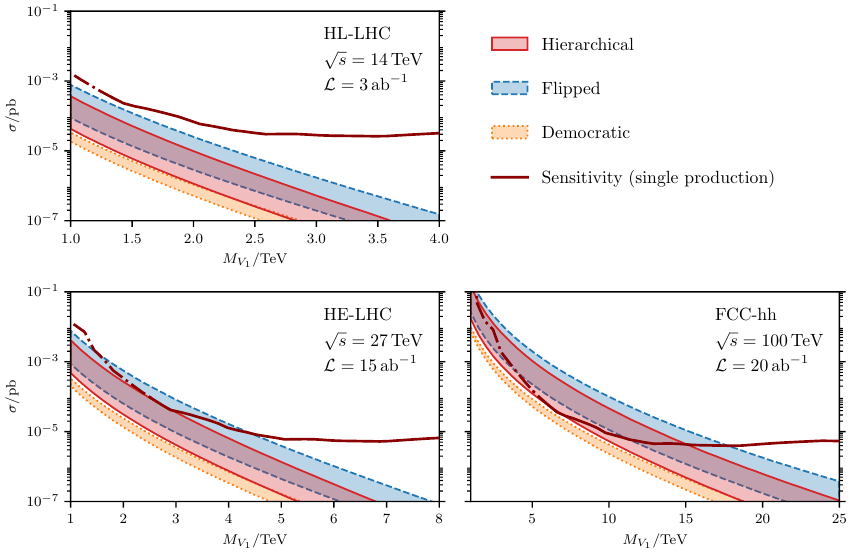
Figure 8 . Comparison of the single leptoquark production cross sections σ ( pp → V ± 2 / 3 the benchmarks (2.9), (2.11), (2.12) at different future colliders, for κ = 0